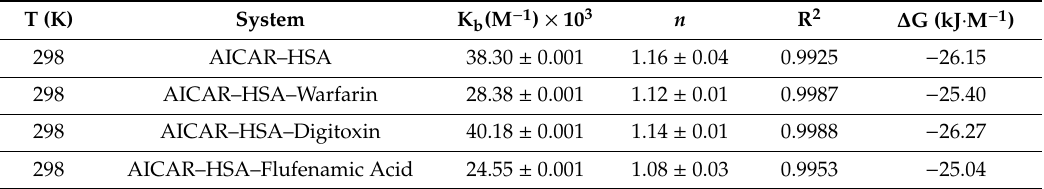
Table 3. Equilibrium binding constants in site-competitive displacement experiments at 298 K.